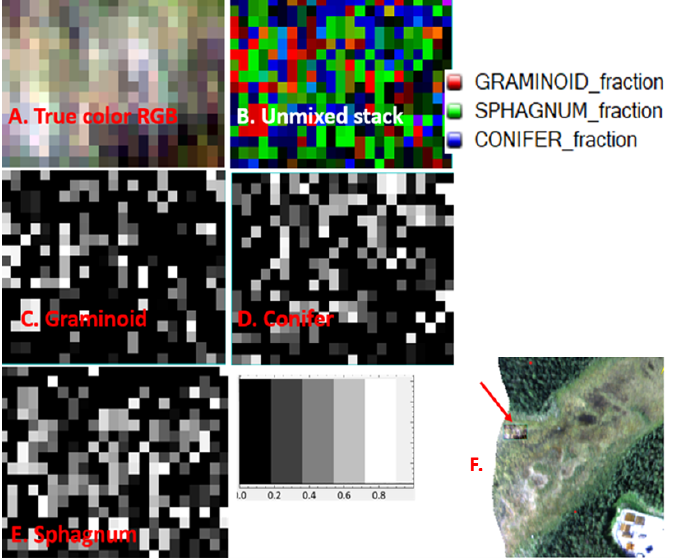
Figure 8. The fractional coverage results from unmixing the small swath of G-LiHT Beaver Creek (Sedge Wetland) pixels. ( A ). True color image. ( B ). RGB stack of unmixed layers representing three classes which are shown individually in ( C – E ): Graminoid (red), Conifer (blue), and Sphagnum (green)). ( C – E ) are fractional PFT coverages from unmixing for each class. ( C : Graminoid, D : Conifer, and E : Sphagnum ). As shown in the scale, lighter colors represent higher percentages of fractional coverage). ( F ). Shows the detail of the Sedge Wetland Class, as part of a full peatland